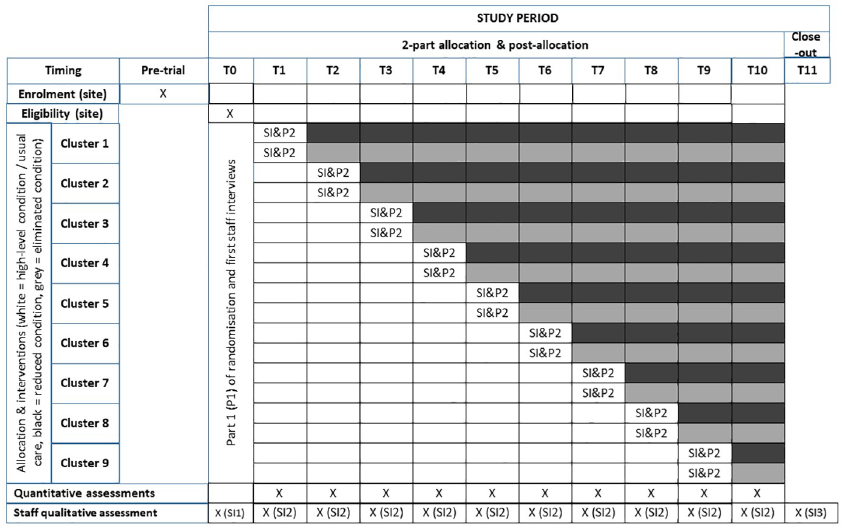
Fig 4. Sprit schedule and trial design with 2-part randomisation (P1&P2) and staff interviews